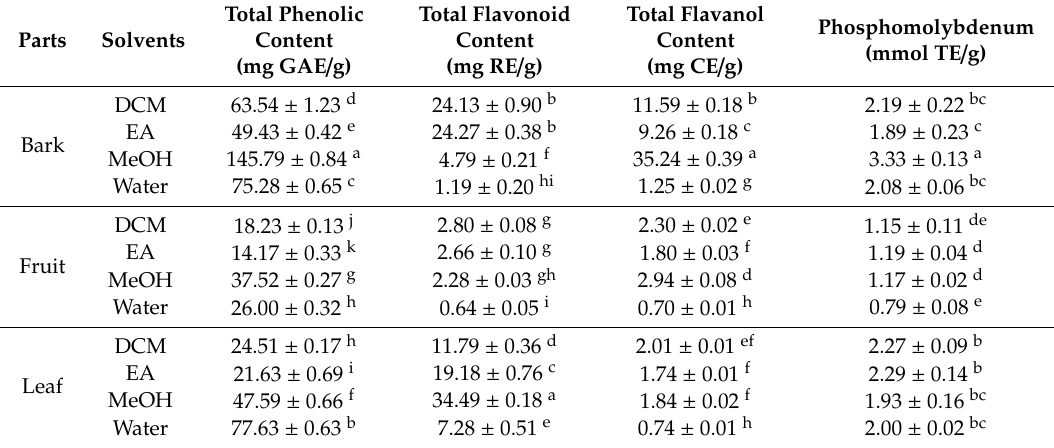
Table 1. Total bioactive compounds and total antioxidant capacity (by phosphomolybdenum assay) of the studied